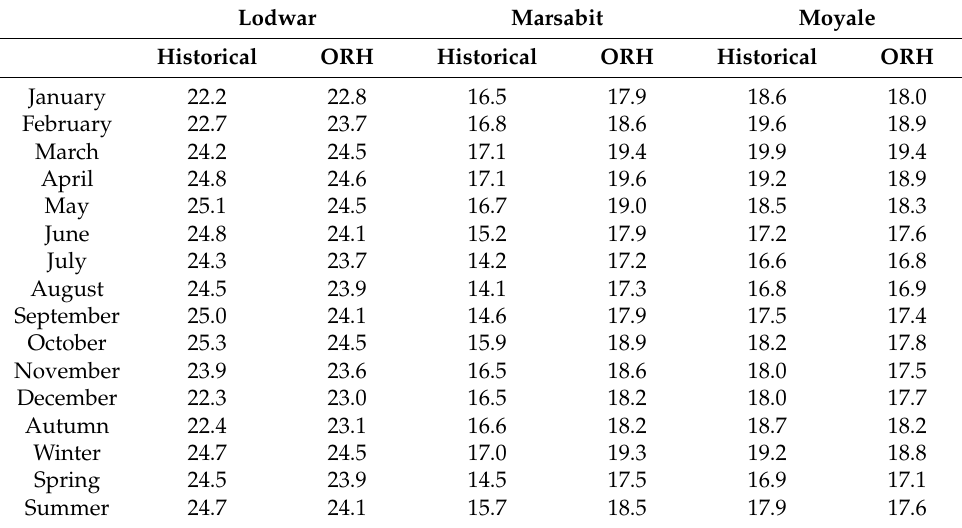
Table A2. Comparison of monthly/seasonal mean value of minimum temperature (values are expressed in ◦ C) obtained from the historical time series and the ORH dataset for the three land- based meteorological stations (Lodwar, Marsabit and Moyale). Lodwar Marsabit Moyale